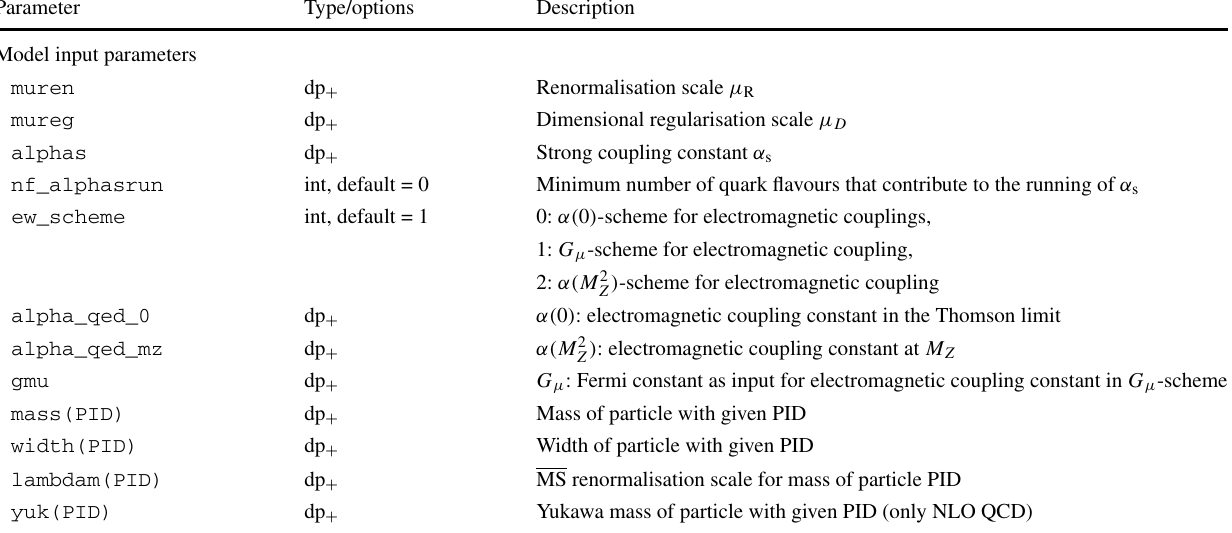
Table 10 Available model input parameters and switches in OpenLoops . Possible input types include dp: double, dp + : positive double, int: integer, and b: integer 0 or 1. For details see Sects.